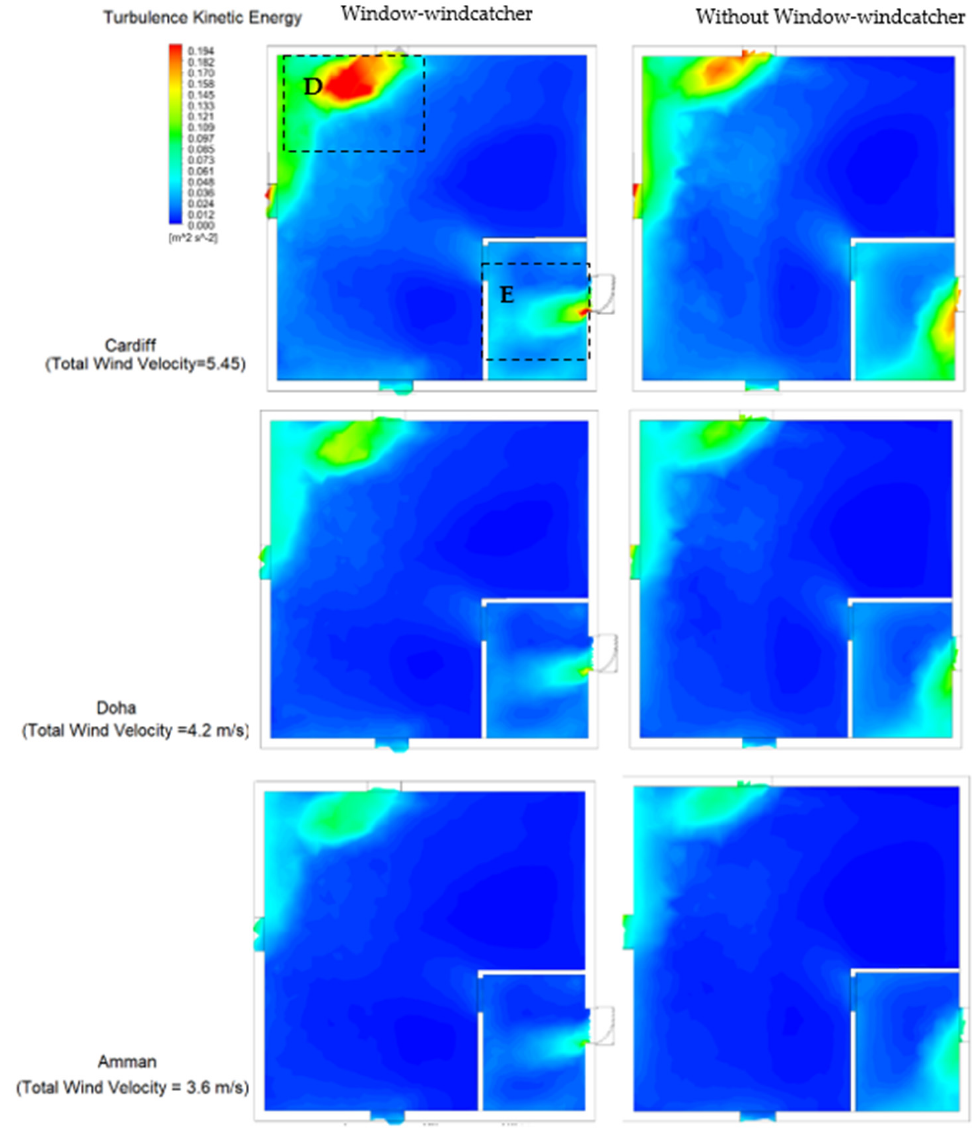
Figure 10. Turbulence kinetic energy profile at the 1.7 m interior plane (D: High-turbulence region, E: Low-turbulence region).